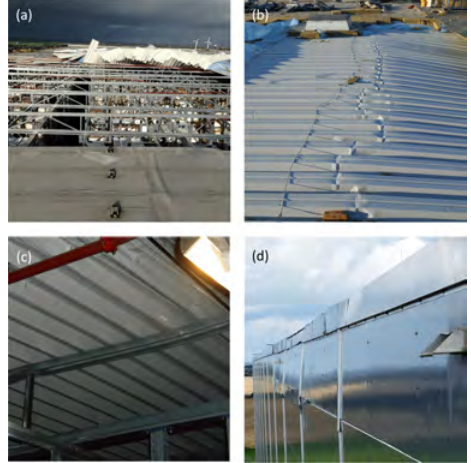
Figure 3. Qualitative description of typical damages: (a) Partically opened roof, (b) buckled sheets, (c) bent girder and (d) deformed parapet.